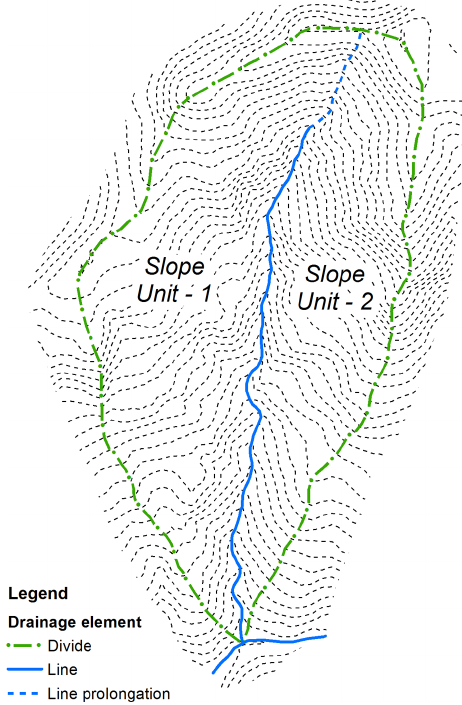
Fig. 7. Scheme of Slope Unit generation.